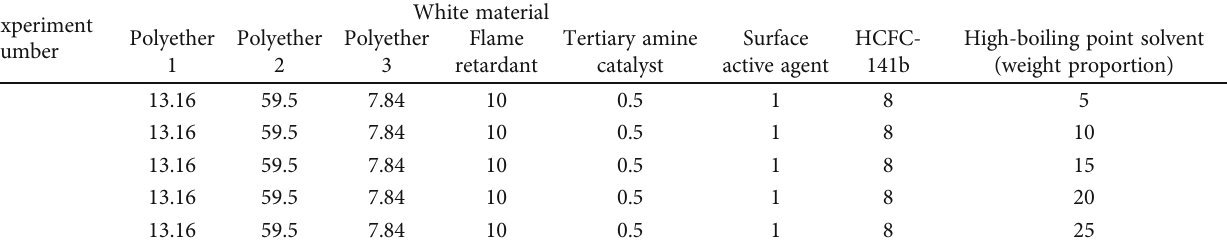
Table 3: Experiment weight proportion scheme of high-boiling point solvent (%).